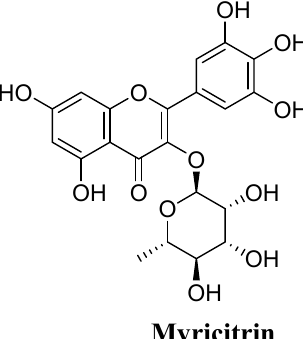
Figure 26. Myricitrin.